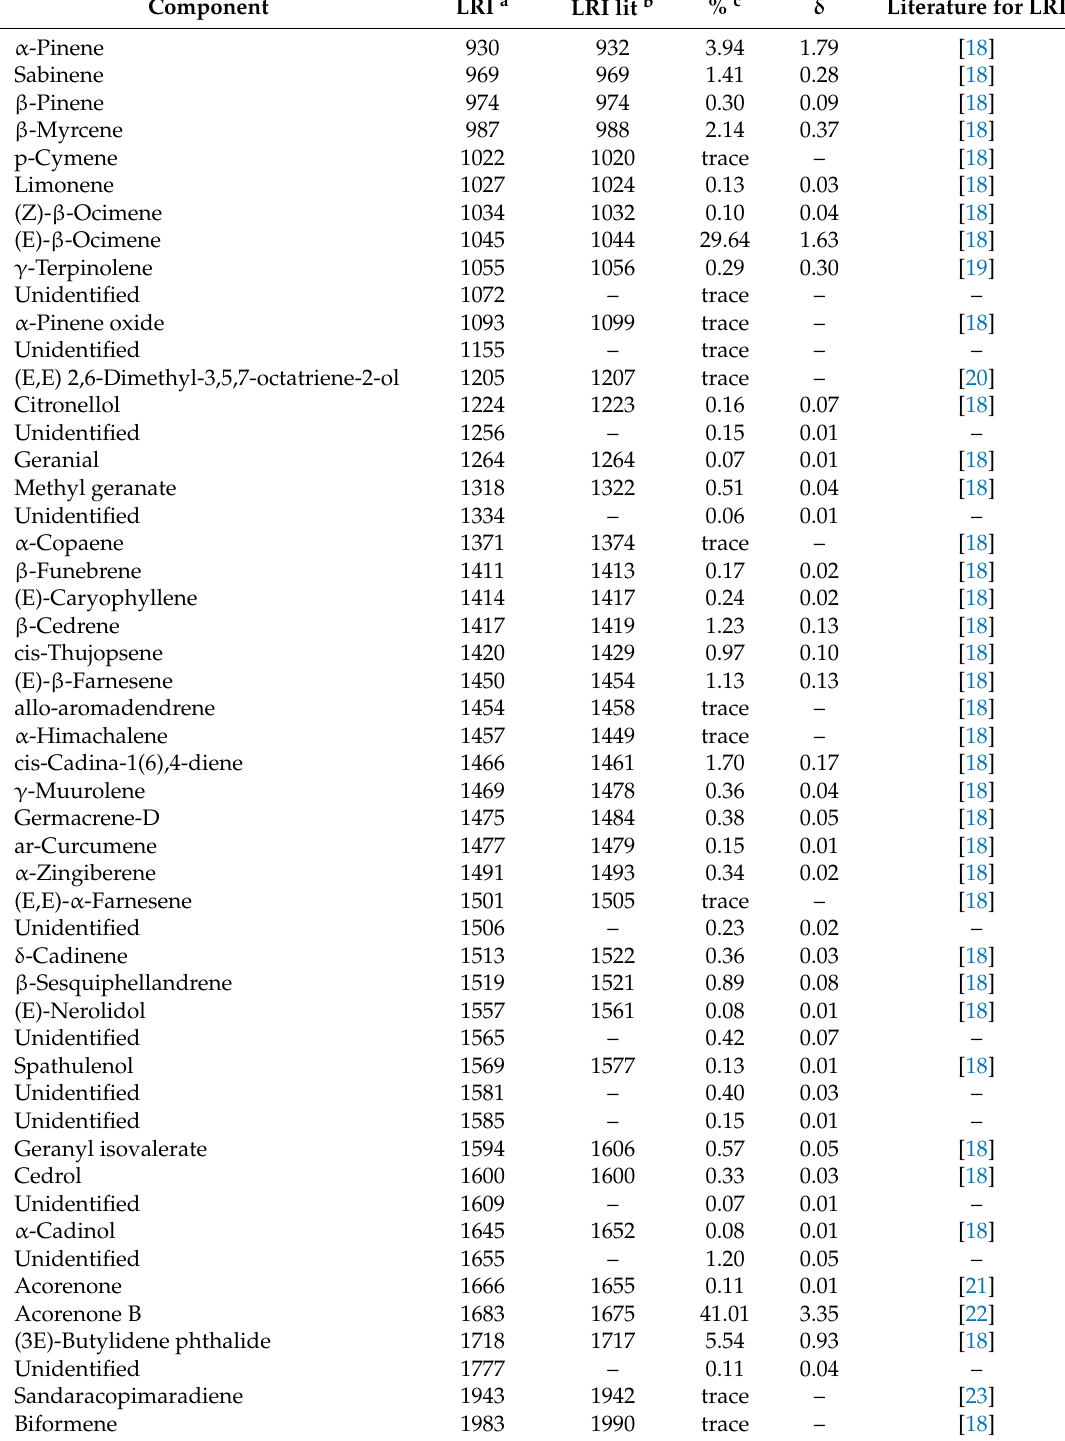
Table 1. Chemical composition of Niphogeton dissecta essential oil of province of Loja, Ecuador.